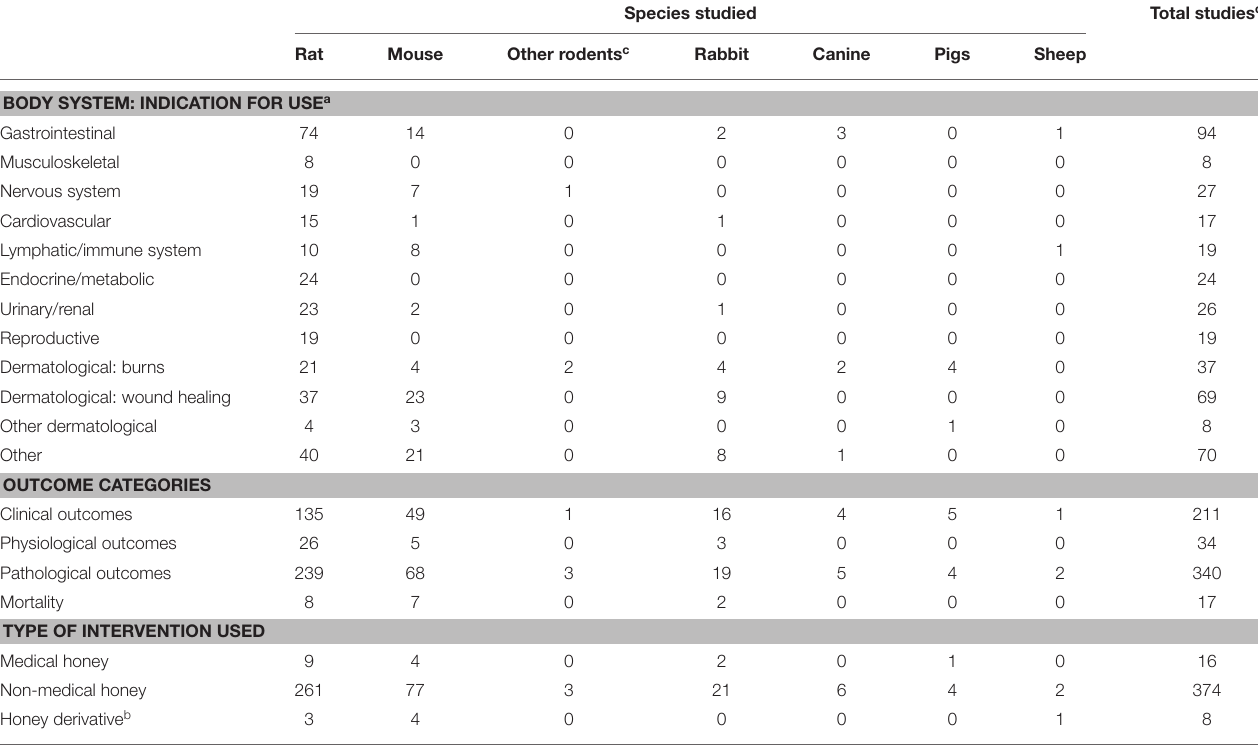
TABLE 5 | Summary of 387 biomedical challenge trials included in a scoping review of the evidence for the medicinal use of honey in animals, characterised by species, indication for use, outcome category and type of honey used. Species studied Total studies d Rat Mouse Other rodents c Rabbit Canine Pigs